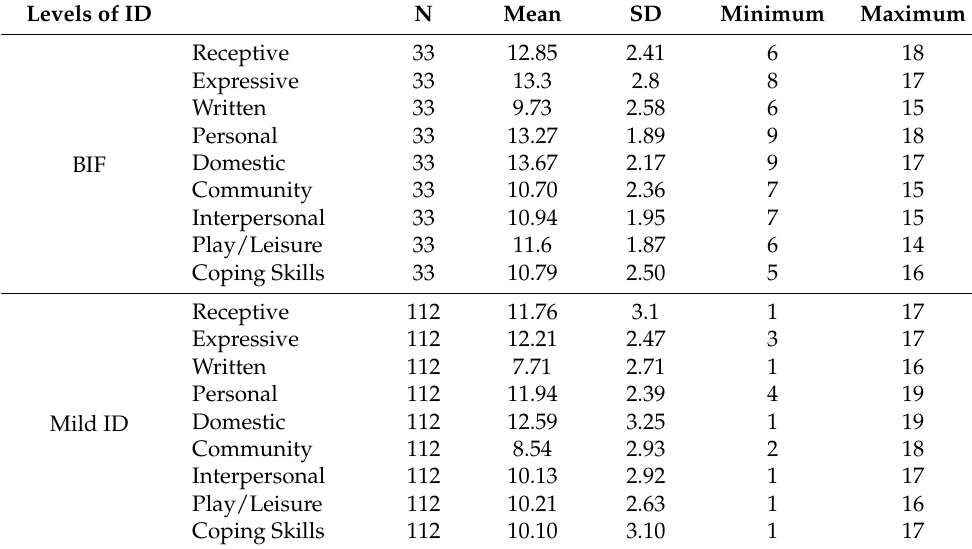
Table A2. Descriptive of subdomains VABS-3 in each level of